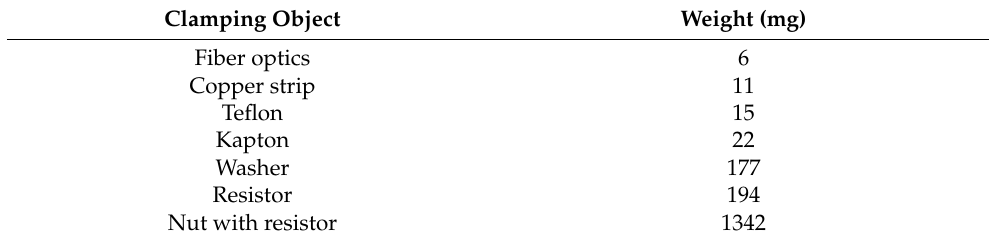
Table 6. Weights of some objects.